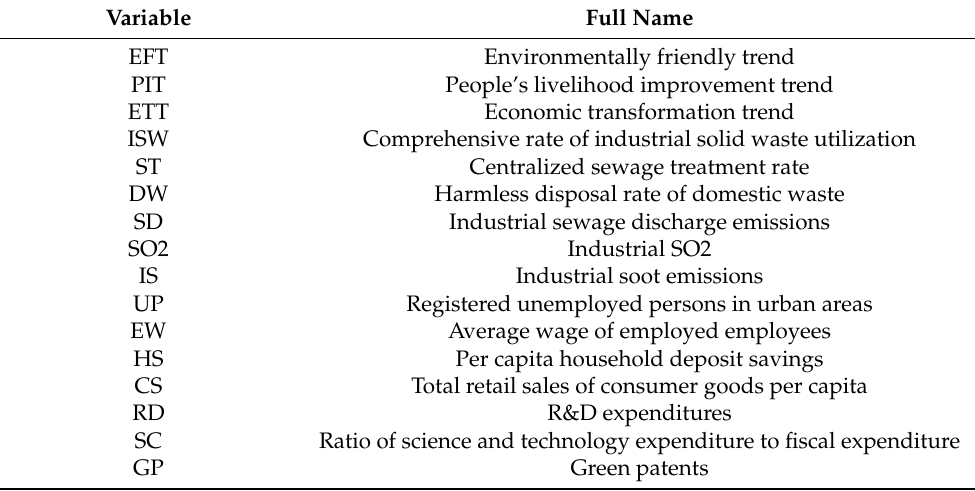
Table A1. Full name of